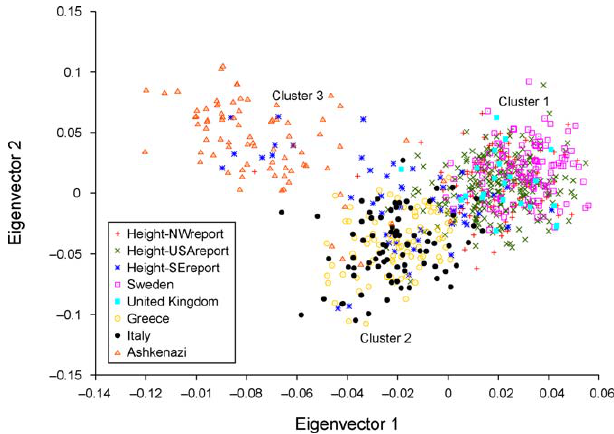
Figure 4. The Top Two Axes of Variation of the Height Samples Together with European Samples Results are based on the 299 markers from our marker panel that are unlinked to the LCT locus. Height samples are labeled according to self- reported grandparental origin: northwest European (Height-NWreport), southeast European (Height-SEreport) or four USA-born grandparents (Height-USAreport).